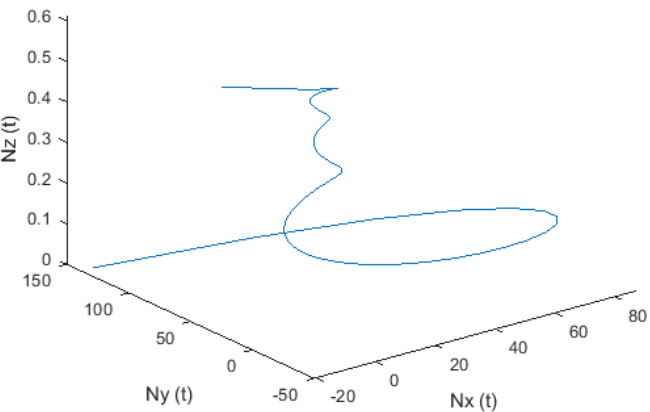
Figure 5. Numerical solutions of the Bloch equation with parameters: α = β = γ = 0.8, w 0 = 12, T 1 = 1, T 2 = 20, a = 1, b = 1.